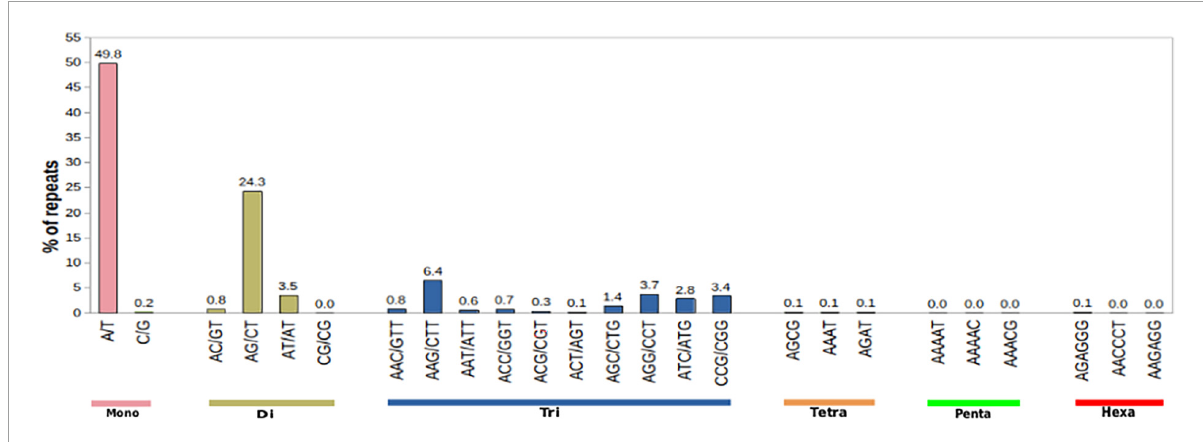
FIGURE9 Distribution of simple sequence repeats (SSRs) in M. acuminata